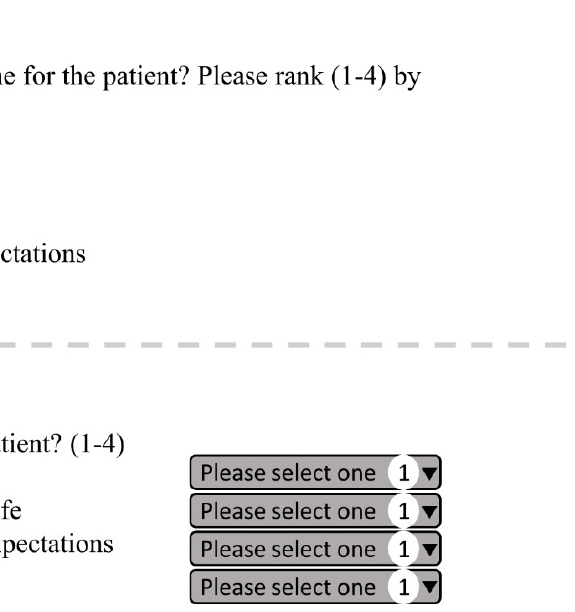
Figure 3. ( A ) Example of ranked series question layout from the round 2 questionnaire. ( B ) Example of ranked series question layout from the round 3 questionnaire. In the round 3 questionnaire, the DELPHI panel was also provided with a summary of the group answers (rank based on the average rank from the previous round results).